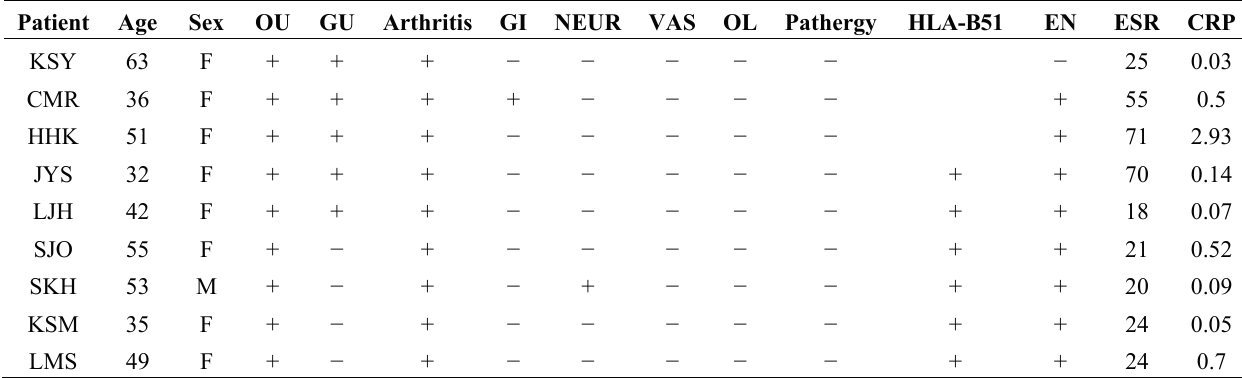
Table 1. Clinical characteristics of Behçet’s Disease